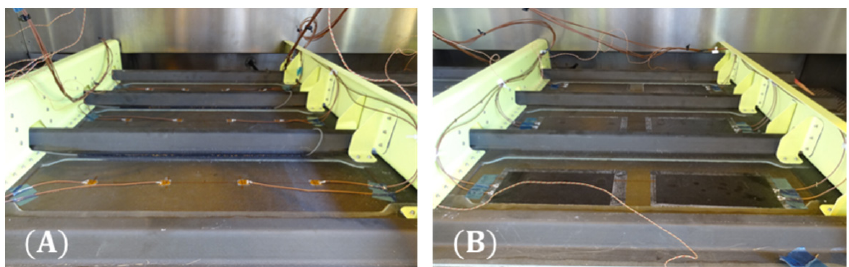
Figure 1. Panel sensorization options ( A ) Fully wired and ( B ) diagnostic film.